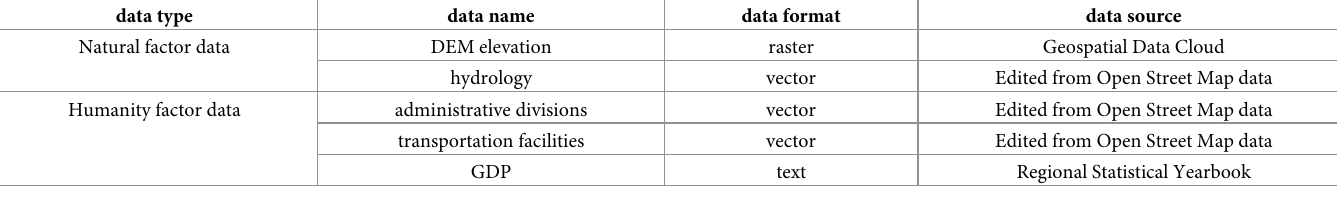
Table 2. Data and data